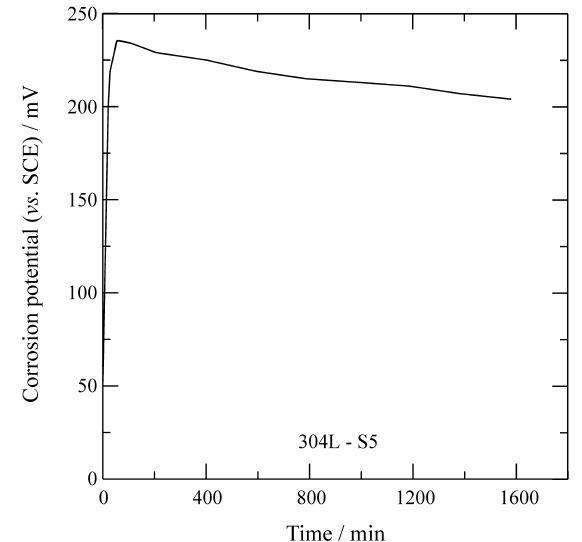
Figure 6. Corrosion potential E corr variation with immersion time in 3.5% NaCl solution for 304LL steel with S3 surface finish.